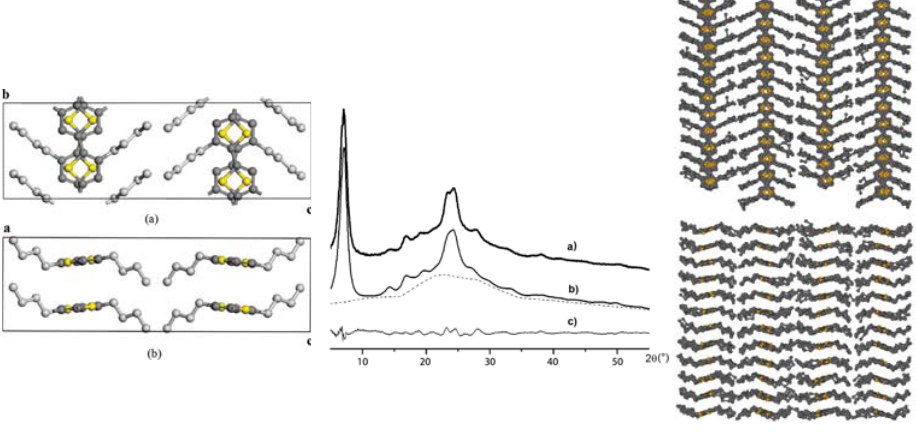
Fig. 2. Results for form I’ of P3BT. On the left, we show two views of its C222 1 unit cell (lattice parameters: a =7.64 Å, b =7.75 Å, c =24.97 Å). In the centre, we show a comparison on the experimental and calculated WAXS profiles. On the right, we show two snapshots from a room-temperature MD simulation of a supercell. Our experimental work was carried out on highly regioregular, low molar mass P3BT samples. These two conditions allow the formation of highly crystalline samples (note that, in a polymeric material, “high crystallinity” may mean <50% of amorphous phase). Indeed, with these samples we found evidence of a new form (called I’) for P3BT, which is similar but more ordered than form I.[9] Tentative unit cells were assigned on the basis of the available diffraction